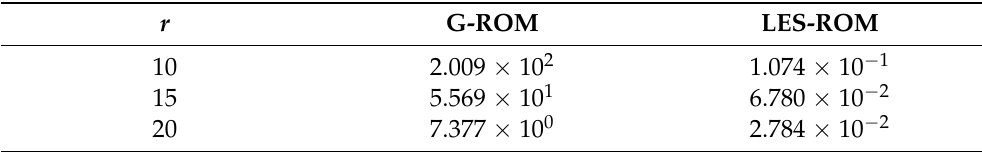
Figure 11. Under-resolved, reconstructive regime. Time-averaged streamfunction, ψ , for FOM, G-ROM, and large eddy simulation (LES)-ROM with r = 10. Under-resolved, reconstructive regime. Relative L 2 errors (36) of the time-averaged streamfunction for G-ROM and LES-ROM for different r